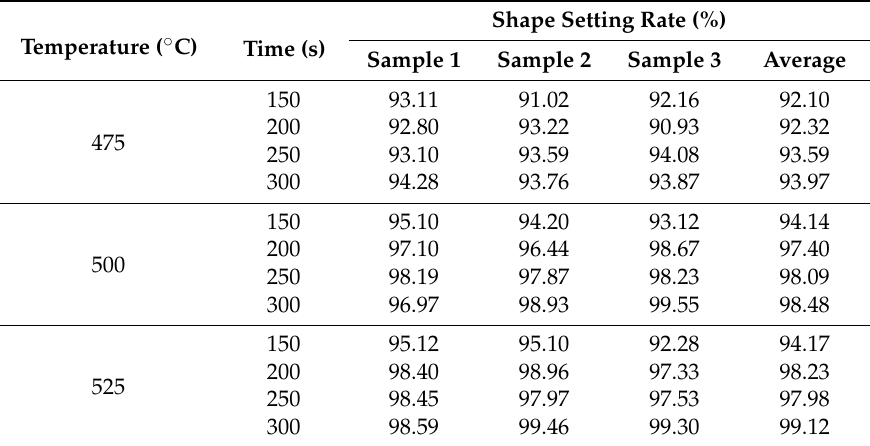
Table 2. Experimental data of the measured shape setting rate.